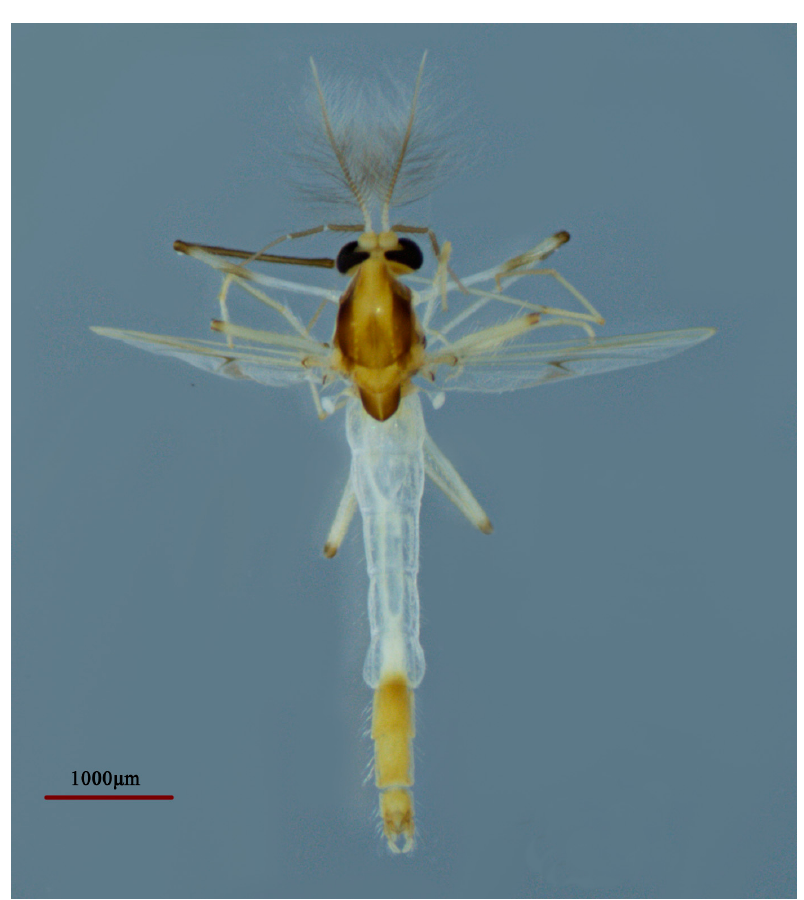
Figure 12. Male adult (holotype, in dorsal view) of Microtendipes wuyiensis sp. nov.